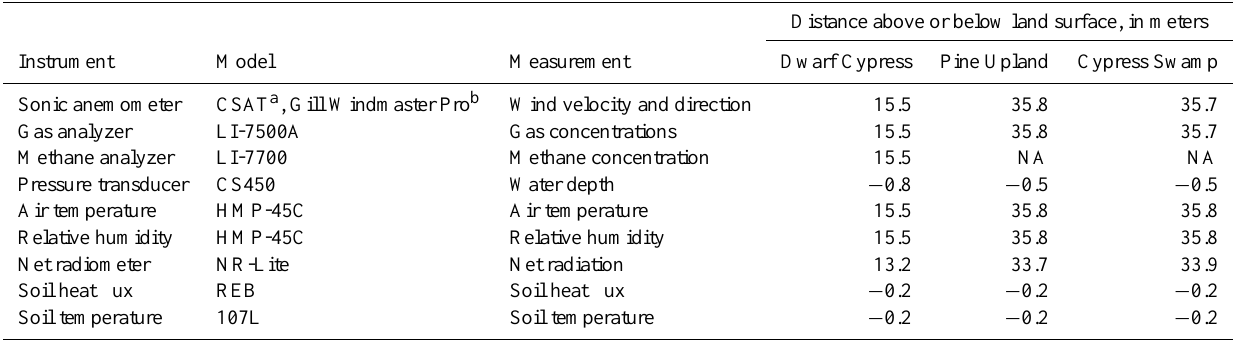
Table 2. Instrumentation installed at the Dwarf Cypress, Cypress Swamp and Pine Upland flux stations.